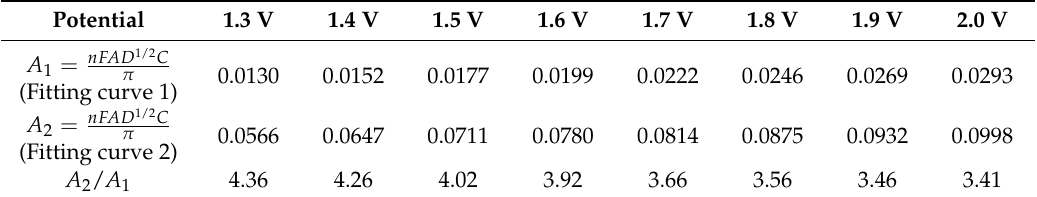
Table 1. Fitting results and active area ratios before and after MnO 2